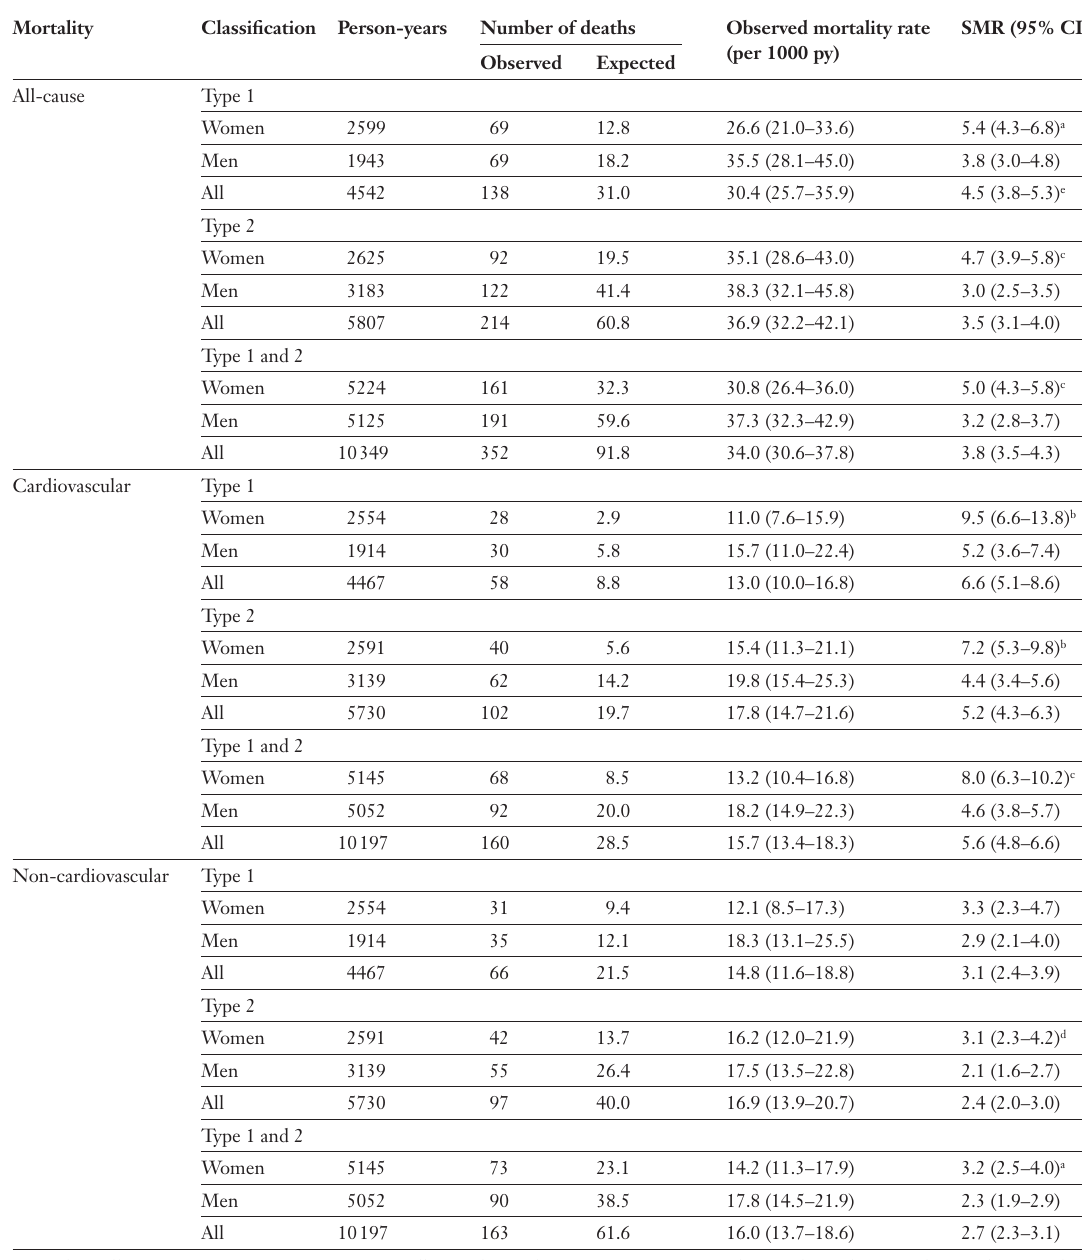
Person-years, ob- served and expected deaths, standardised mortality